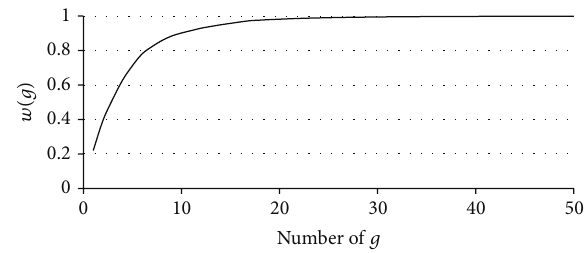
Figure 16: Function 𝑤(𝑔) for the multilayer sheet structure (POD with inner weighting).